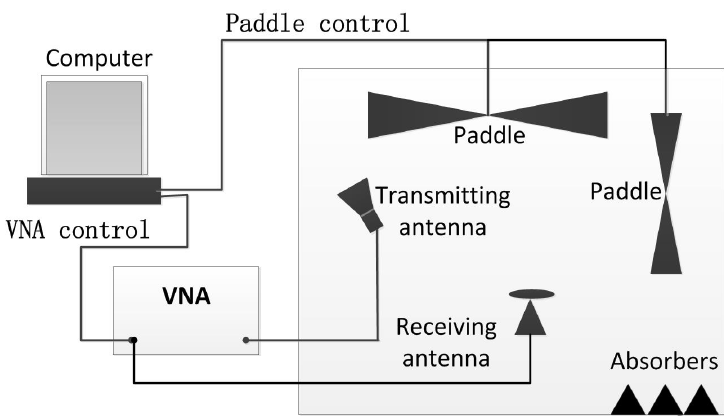
Figure 9. RMS (root-mean-square) delay spread measurement setup in the NIM RC.